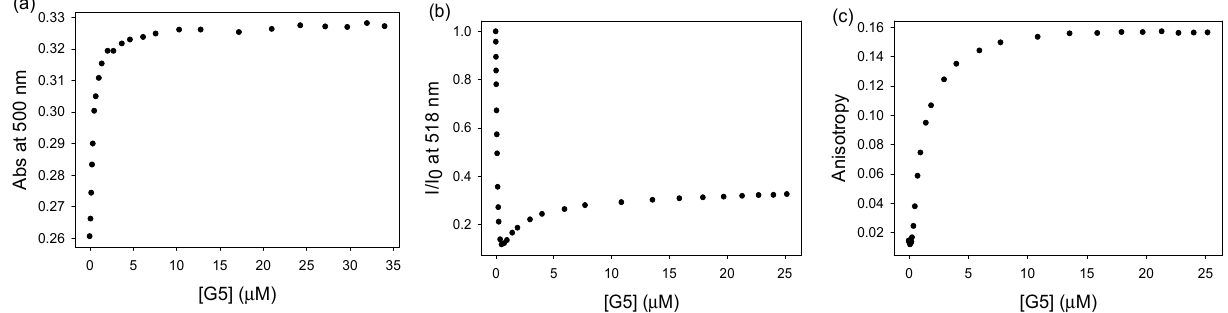
Figure 1. Titration of G5 into calcein to form [calcein•PAMAM] complex in solution. ( a ) Absorbance; ( b ) fluorescence emission intensity; ( c ) fluorescence anisotropy. [calcein] = 6.36 µ M, [PAMAM G5] = 2.13 µ M. Performed in 50 mM aqueous HEPES buffer at pH 7.4, T = 25 °C, excitation: 496 nm, emission: 518 nm.